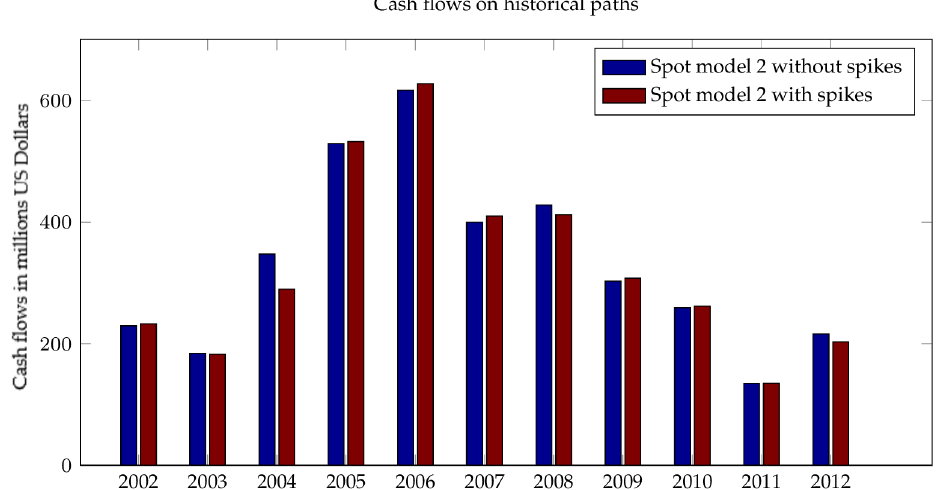
Figure 12. Cash flows on historical